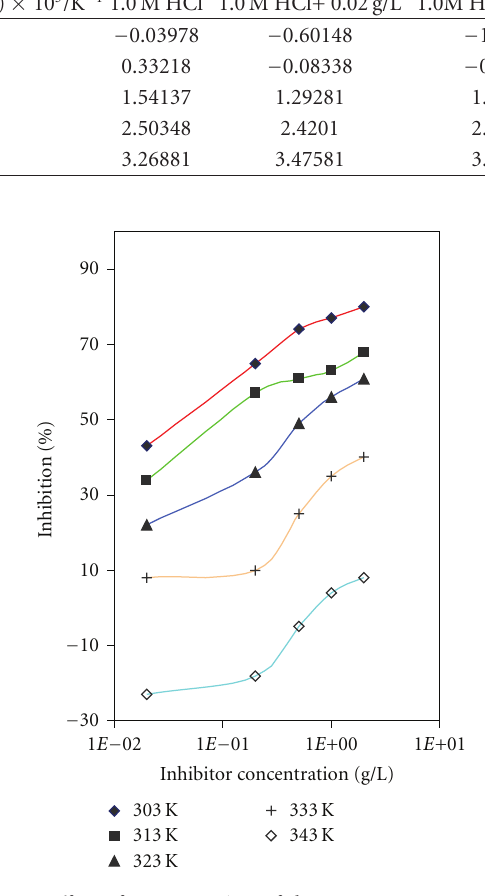
Figure 7: E ff ect of concentration of the aqueous extract of Neem leaves on the percent inhibition of carbon steel in 1.0M HCl at various temperatures.